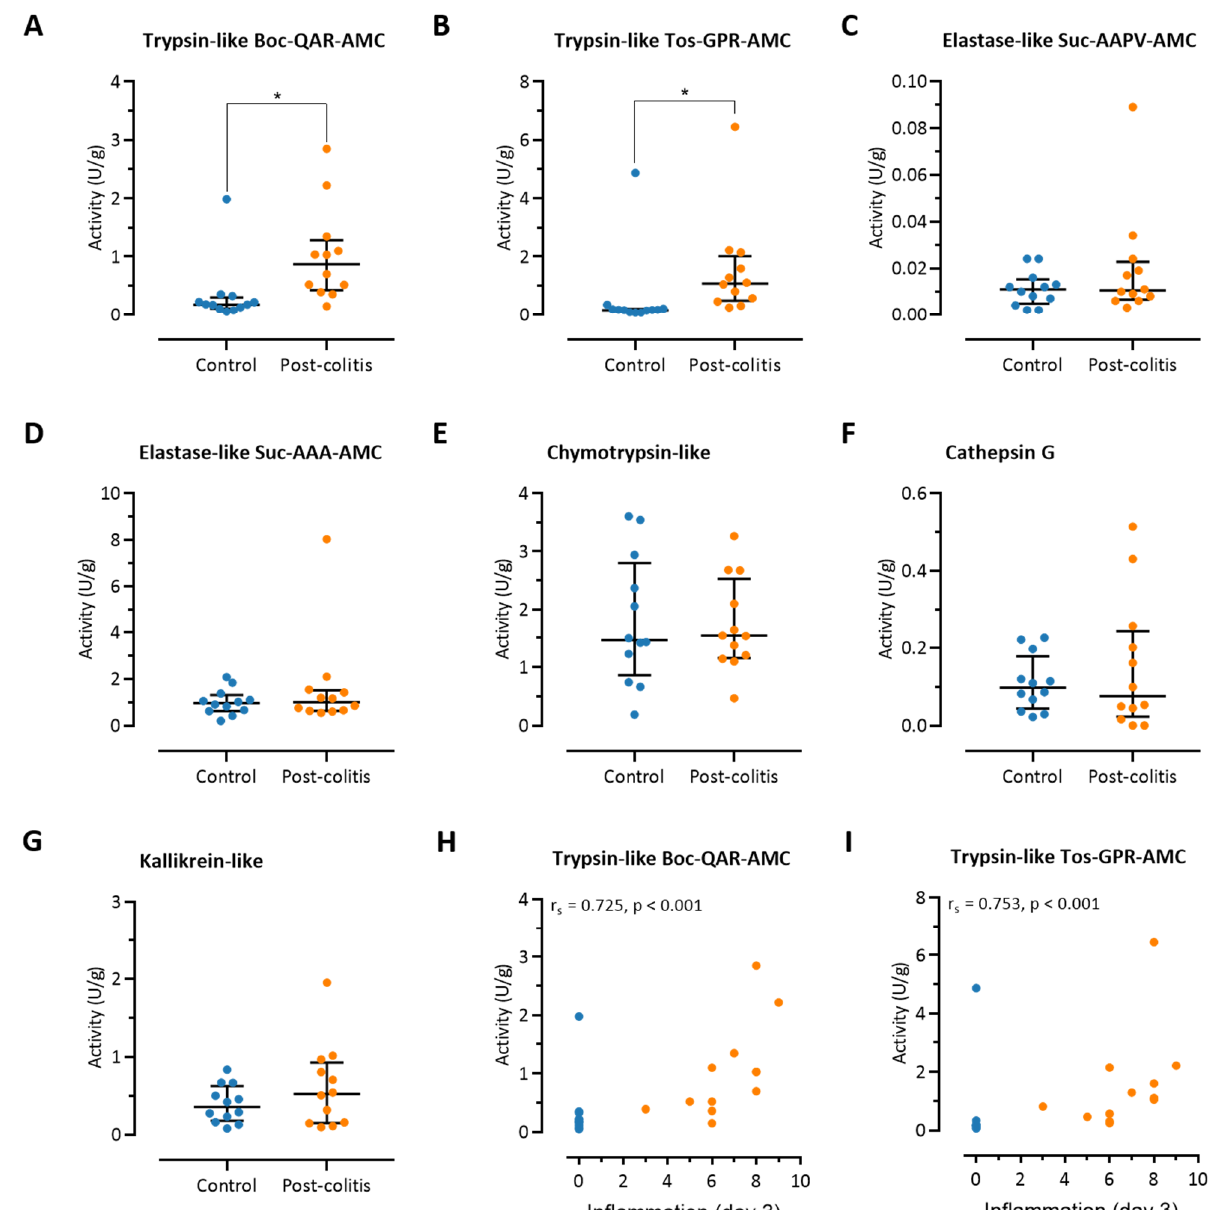
Figure 3. Proteolytic activities in colonic tissue of post-colitis and control rats. ( A ) Trypsin-like activity assessed using the substrate Boc-Gln-Ala-Arg-AMC. ( B ) Trypsin-like activity assessed using the substrate Tos-Gly-Pro-Arg-AMC. ( C ) Elastase-like activity assessed using the substrate Suc-Ala-Ala-Pro-Val-AMC. ( D ) Elastase-like activity assessed using the substrate Suc-Ala-Ala-Ala-AMC. ( E ) Chymotrypsin-like activity. ( F ) Cathepsin G activity. ( G ) Kallikrein activity. Proteolytic activities were analyzed using two-way ANOVA with ‘treatment’ and ‘group’ factors, followed by Mann–Whitney U tests with Bonferroni correction for multiplicity; n = 12 per group. Analysis was performed on the full dataset (involving the 4 combinations of control/post-colitis and vehicle/UAMC-00050), however visualization is split across Figures 3, 6, and S1 to allow for easier interpretation of the data. Data are presented including the median and IQR. ( H ) Correlation between the severity of inflammation in the acute phase of colitis (day 3) and trypsin-like activity (Boc-Gln-Ala-Arg-AMC substrate). ( I ) Correlation between the severity of inflammation in the acute phase of colitis (day 3) and trypsin-like activity (Tos-Gly-Pro-Arg-AMC substrate). Correlations were assessed using Spearman’s rank order correlation coefficient, employing the Holm–Bonferroni method to correct for multiplicity. Note: * p < 0.05; significantly different from control.